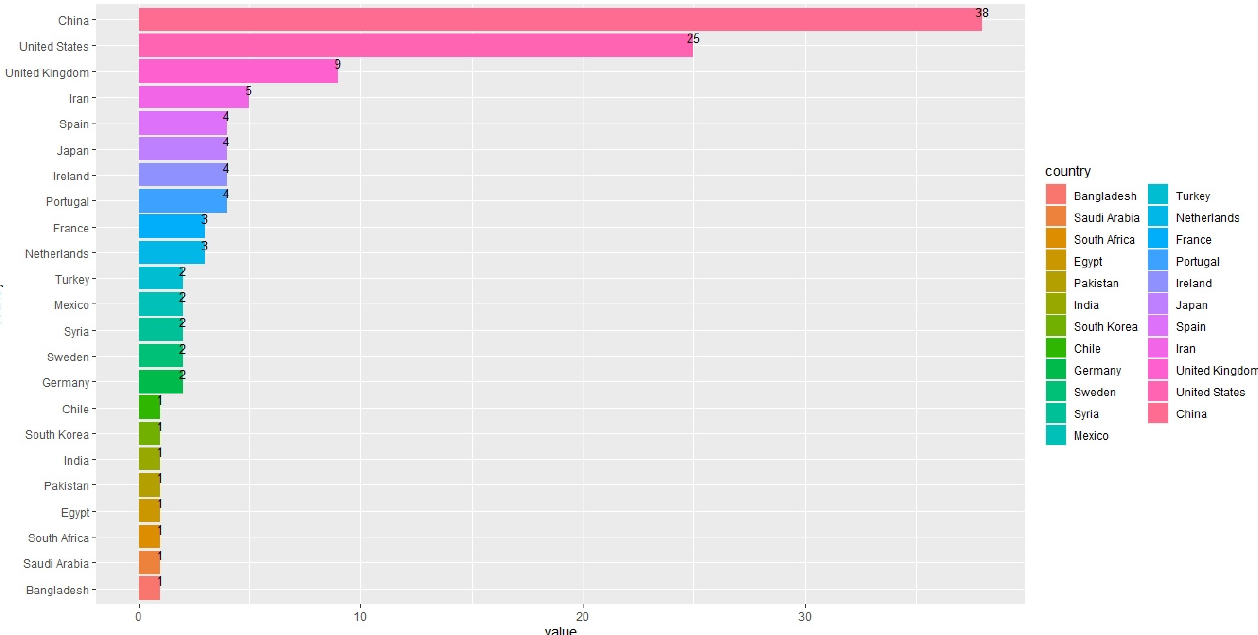
Figure 5. Publication outlets from the primary studies.